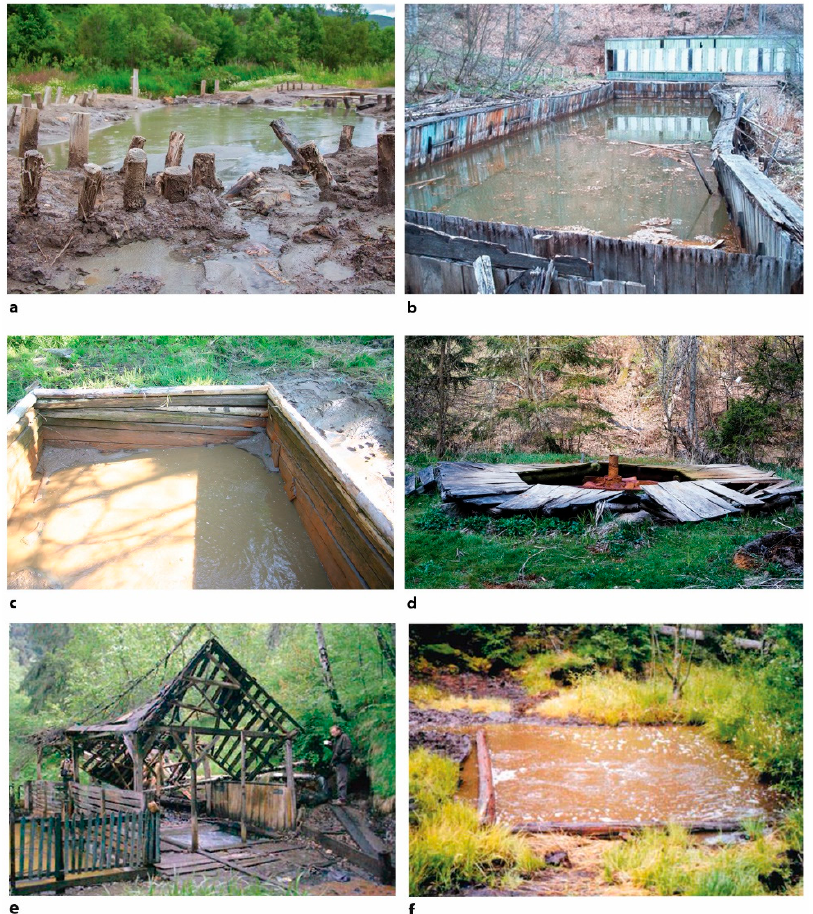
Figure 6. Ruined traditional baths in the 1990s: ( a )—Parajdfürd ő , ( b , e )—Csiszárfürd ő , ( c )— Hammasfürd ő , ( d )—Szelterszfürd ő , ( f )—Vallató (source: Ars Topia Foundation).